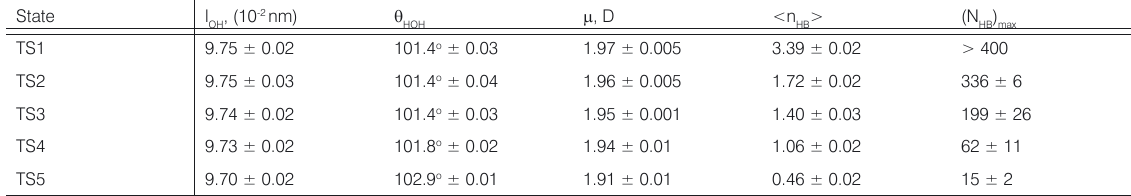
, bond angle θ , dipole OH HOH ) is given in HB max